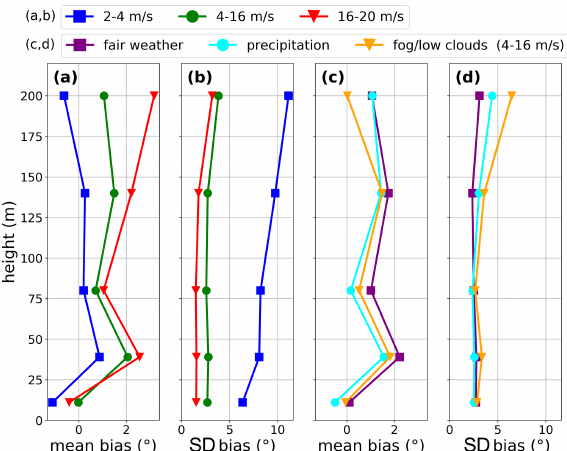
Figure 12. Profiles of the biases in the wind direction for dif- ferent wind speed classes and meteorological conditions. Pan- els (a, b) show the mean bias and standard deviation of the bias applied to three different wind speed classes: 2–4ms − 1 (blue squares), 4–16ms − 1 (green circles) and 16–20ms − 1 (red trian- gles). Panels (c, d) show the mean bias and standard deviation of the bias applied to three different meteorological conditions (and wind speed is bounded to the 4–16ms − 1 range): fair weather (pur- ple squares), precipitation (cyan circles) and fog/low clouds (orange